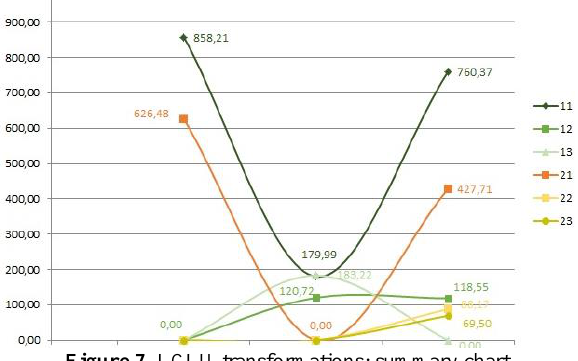
Figure 7 . LCLU transformations: summary